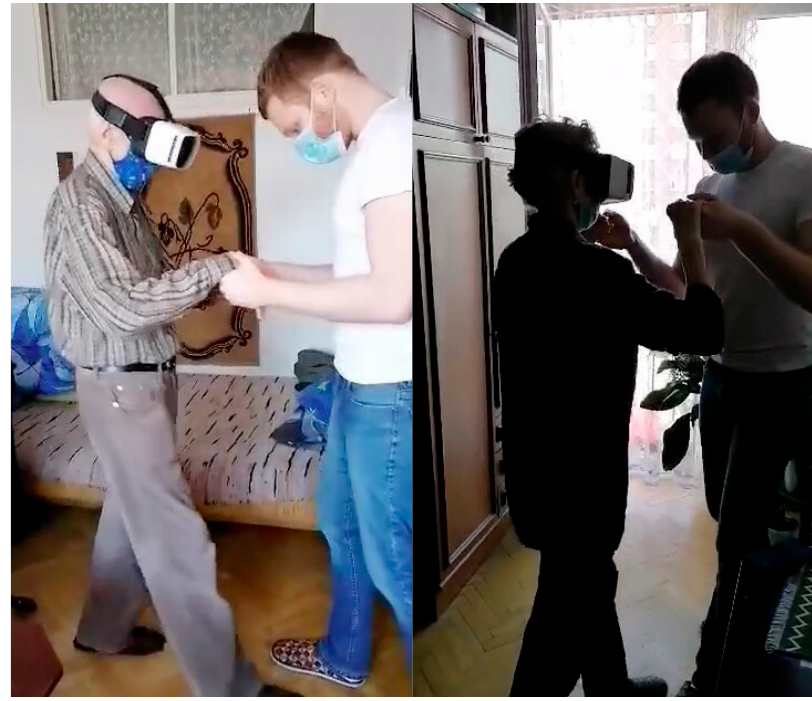
Figure 2. Therapy session aided by Carl Zeiss VR ONE plus device.